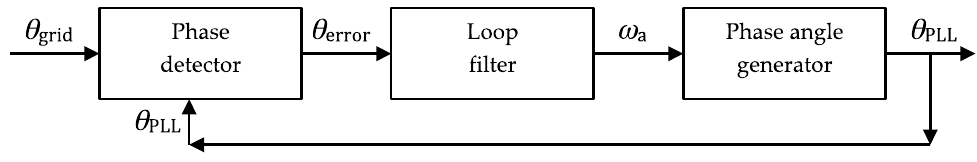
Figure 3. Basic scheme of a phase-locked loop (PLL).